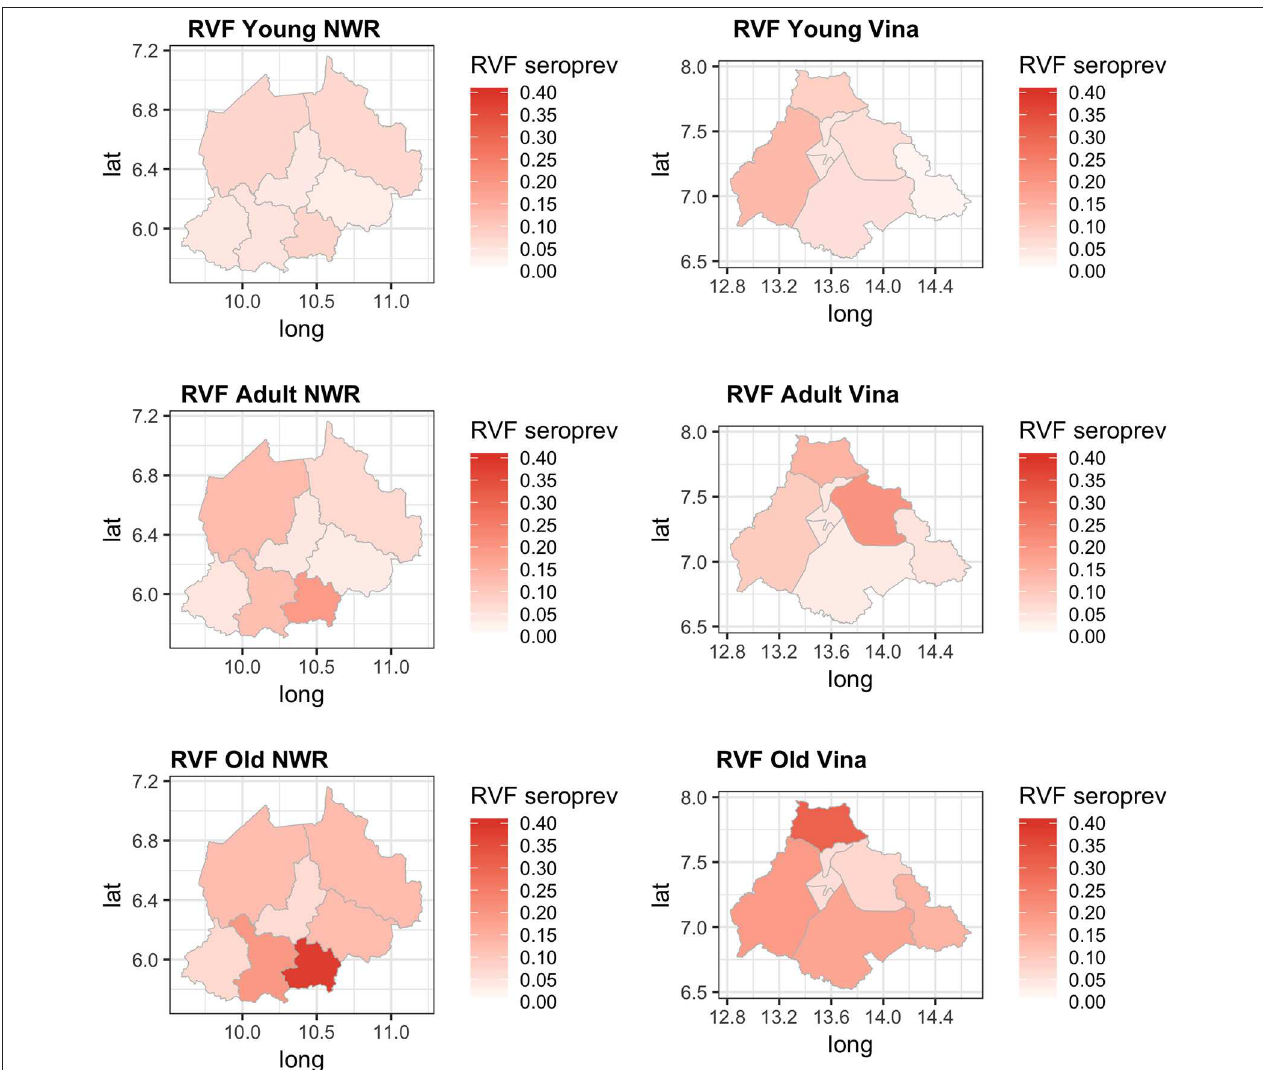
FIGURE 6 | Chloropeth maps showing the two study sites of the Northwest (Divisions) and Vina Division (sub-Divisions) of Cameroon and the Bayesian NGS mean seroprevalence estimates for the three age classes from young adult and old.